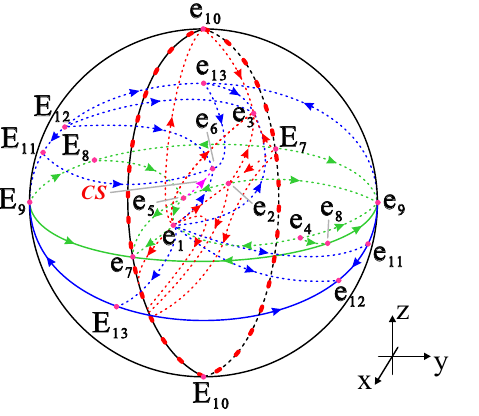
Figure 5. Phase portraits of system (21) on three invariant planes when α → 1 − .